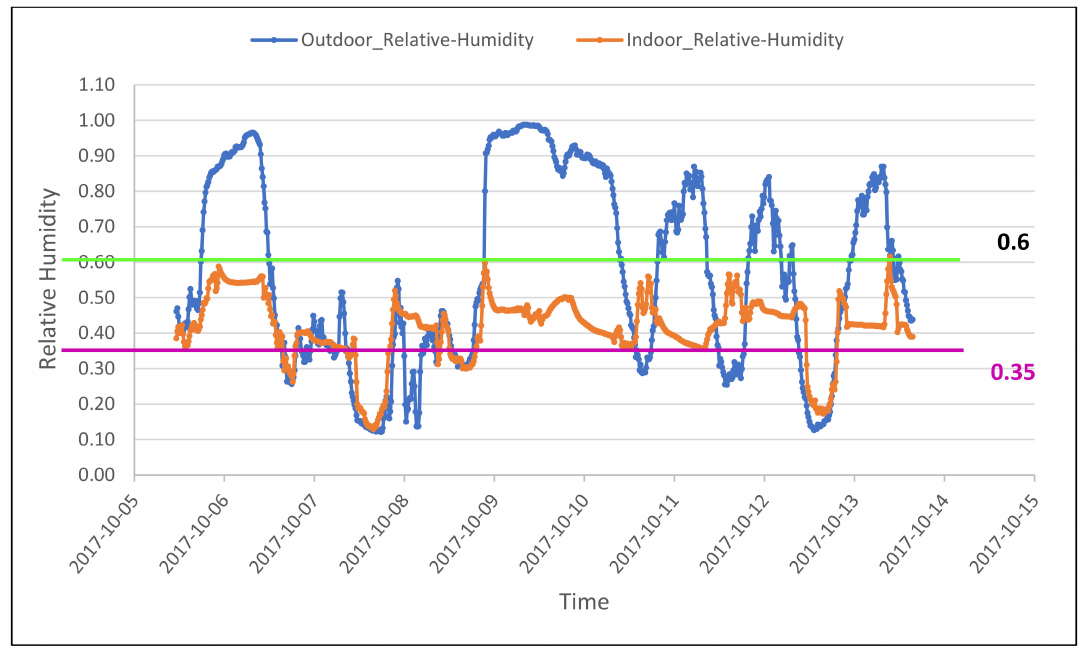
Figure 7. Measured indoor relative humidity and outdoor humidity showing the acceptable